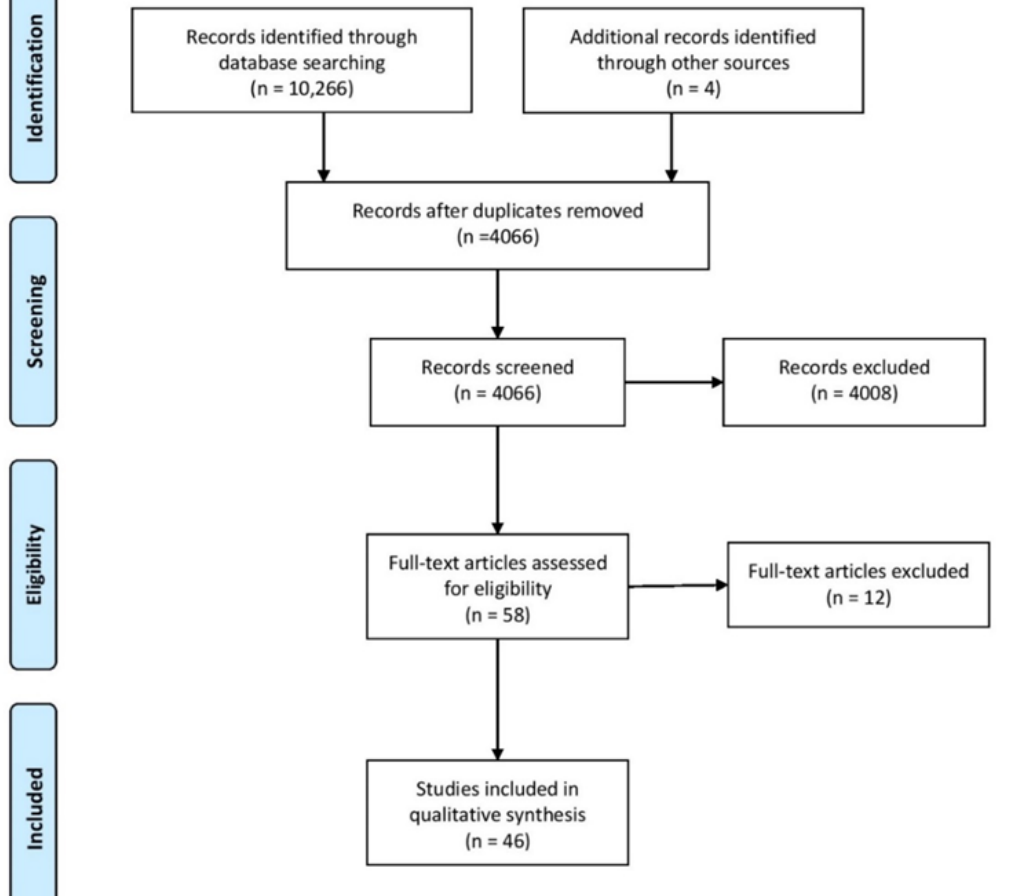
Figure 1. Preferred Reporting Items for Systematic Reviews and Meta-Analyses (PRISMA)